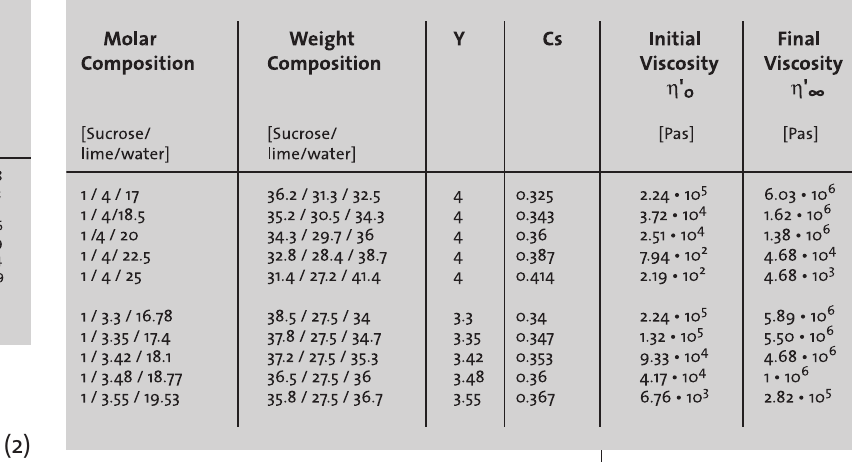
Table 2 (left): Initial and final viscosities of molasses/lime/water sys- tem (Y = 3.55). Table 3 (right): Initial and final viscosities of sucrose/lime/water